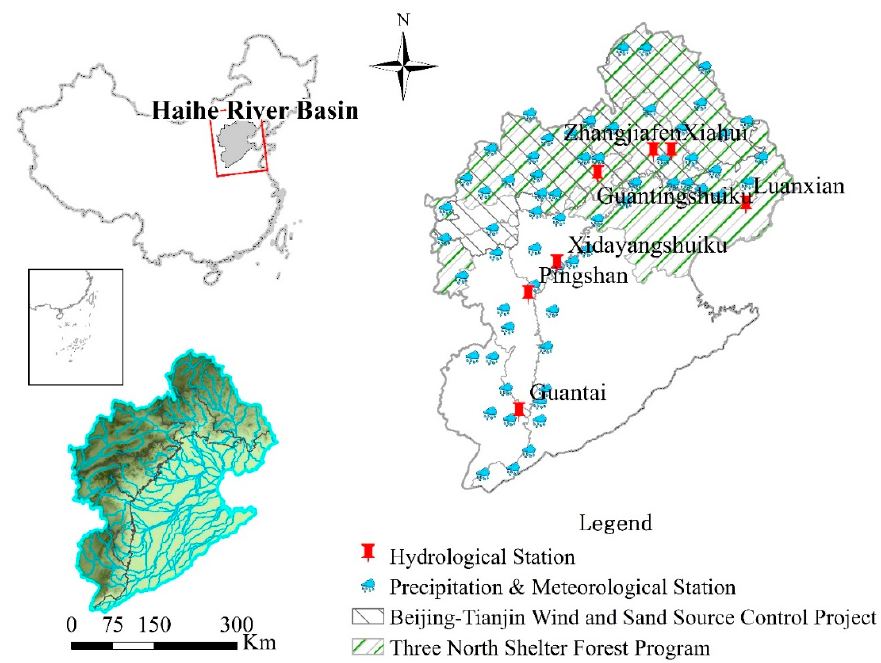
Figure 1. Areas encompassing the implementation of the Three North Shelter Forest Program and Beijing-Tianjin Wind and Sand Source Control Project in the Haihe River Basin, as well as the distribution of hydrological stations.